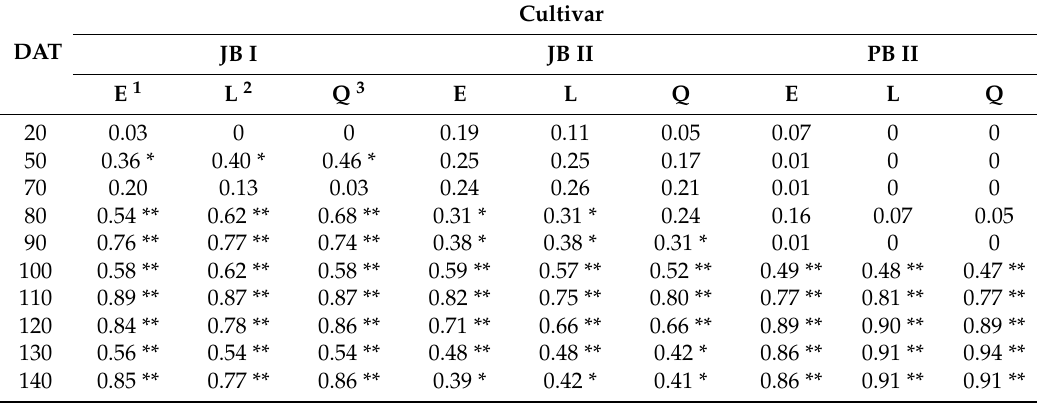
Table 2. The correlation coefficients (R 2 ) between NDVI measurements and cabbage yield of JB cultivar in year I and II and PB cultivar in year II using three different